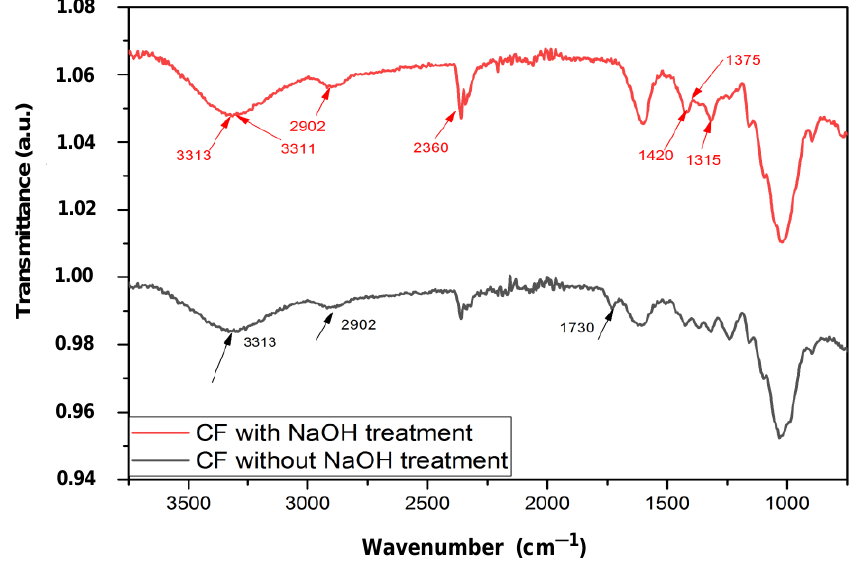
Figure 2. Curauá fiber FTIR (CF) with and without treatment with 5% NaOH. Figure 2. Curau á fiber FTIR (CF) with and without treatment with 5%